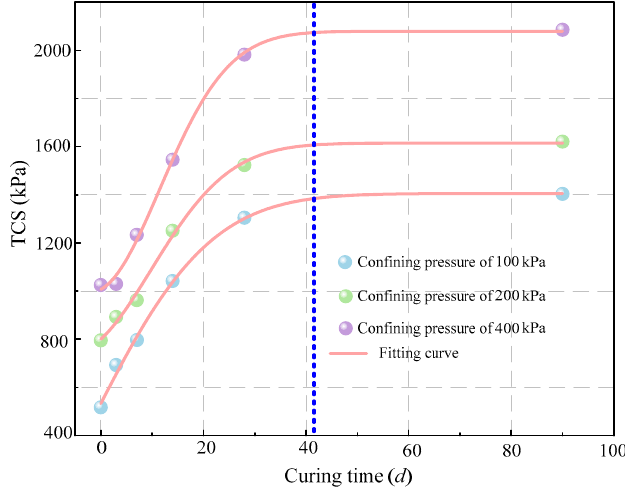
Figure 5. TCS (triaxial compressive strength) of hydrated sample after different curing times under three different confining pressures. Table 5. Parameters obtained from the Gaussian curve analysis of solidified/stabilized gold tailings with different confining pressures.